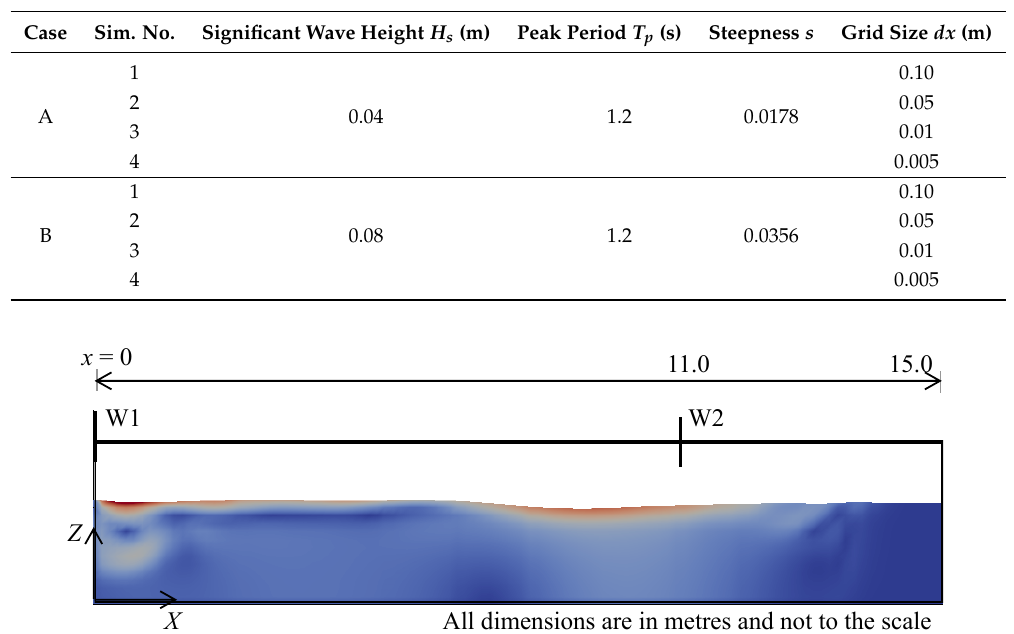
Figure 1. Numerical wave tank setup for the grid refinement study (coloured with the velocity